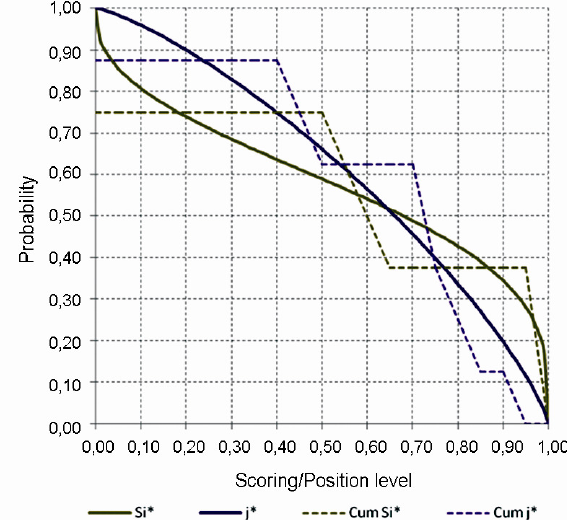
Fig. 1. Single bidder Scoring ( Si *) and Position ( j *) perfor- mance representation In Table 2, quadratic correlation coefficients